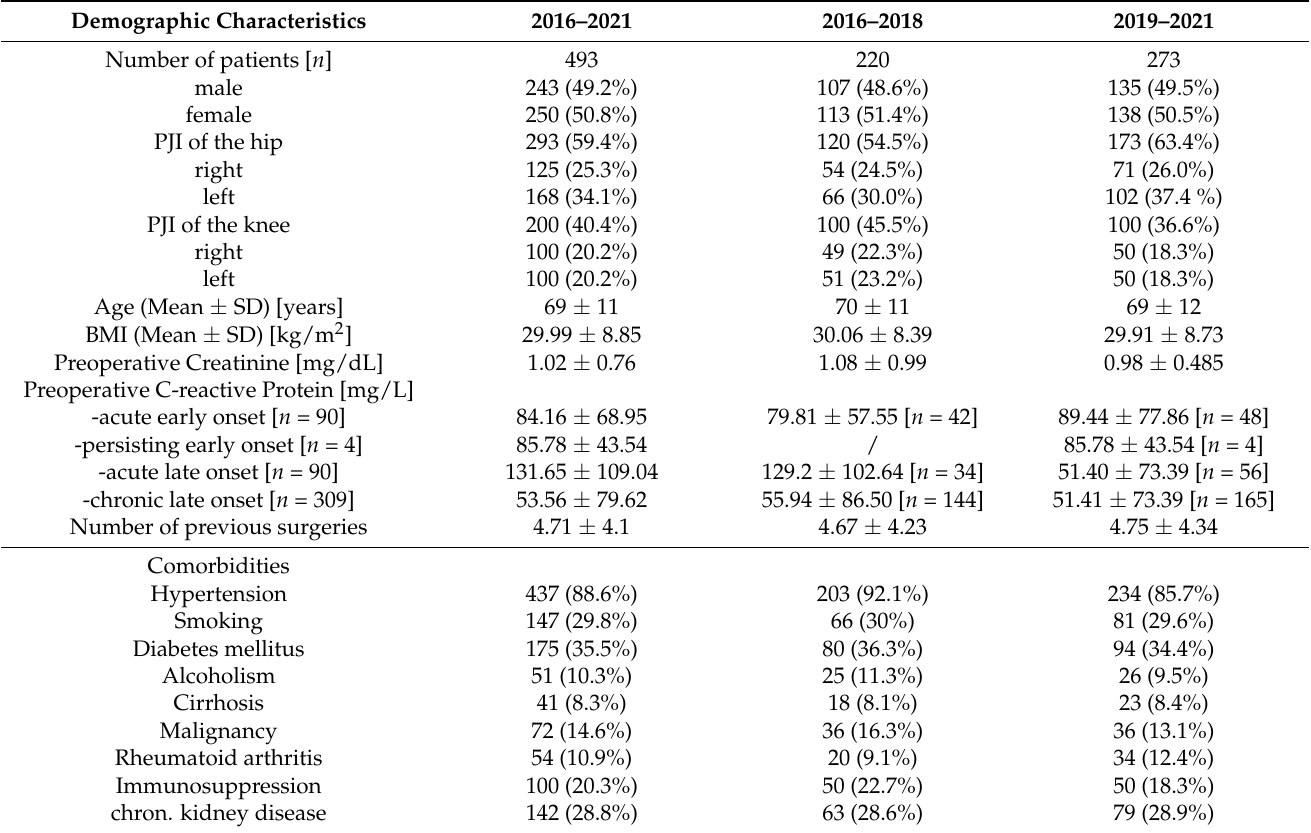
Table 1. Demographics of hip and knee periprosthetic joint infections. Demographic